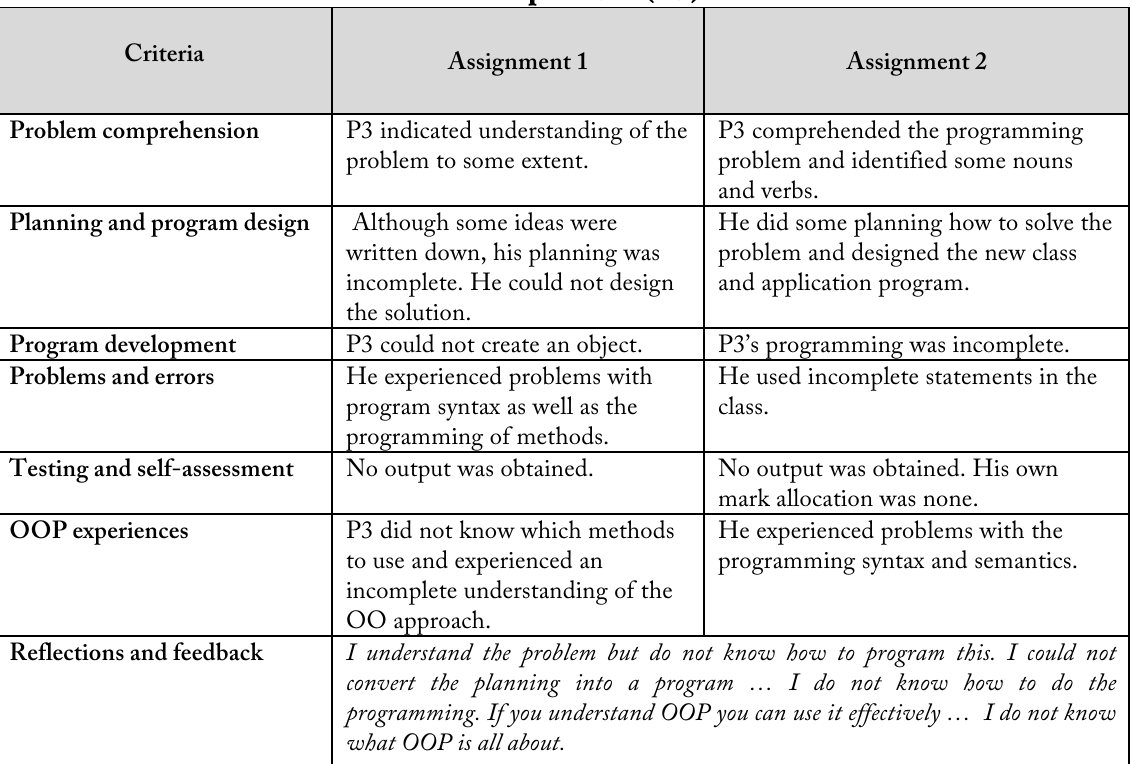
Table 4: Participant 3’s (P3) results